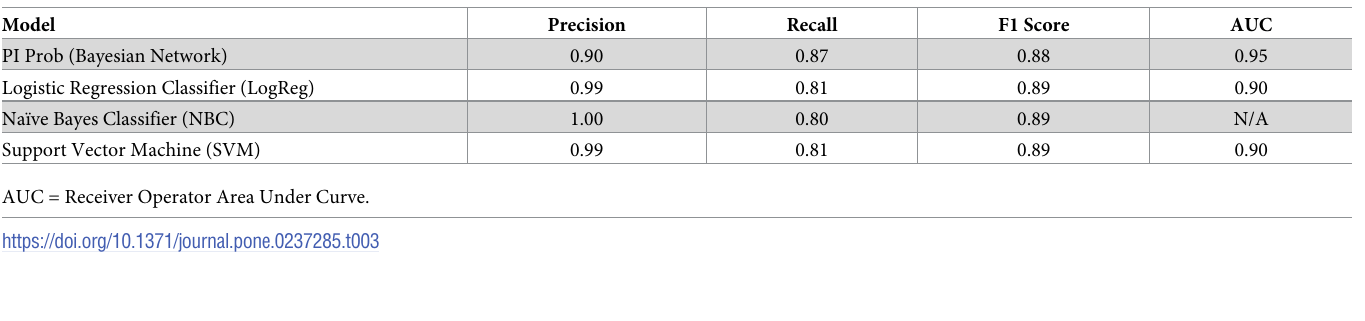
Table 3. Model performance